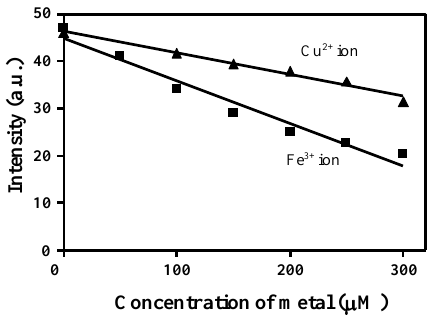
Figure 6. Fluorescence responses of BS2 (2 µM) in the presence of copper (▲) or iron ( ■ ) ions (0–300 μM) in aqueous solution (30 mM HEPES buffer, pH 7.4, 1% DMSO). Excitation at 340 nm (slit = 5.0/5.0).